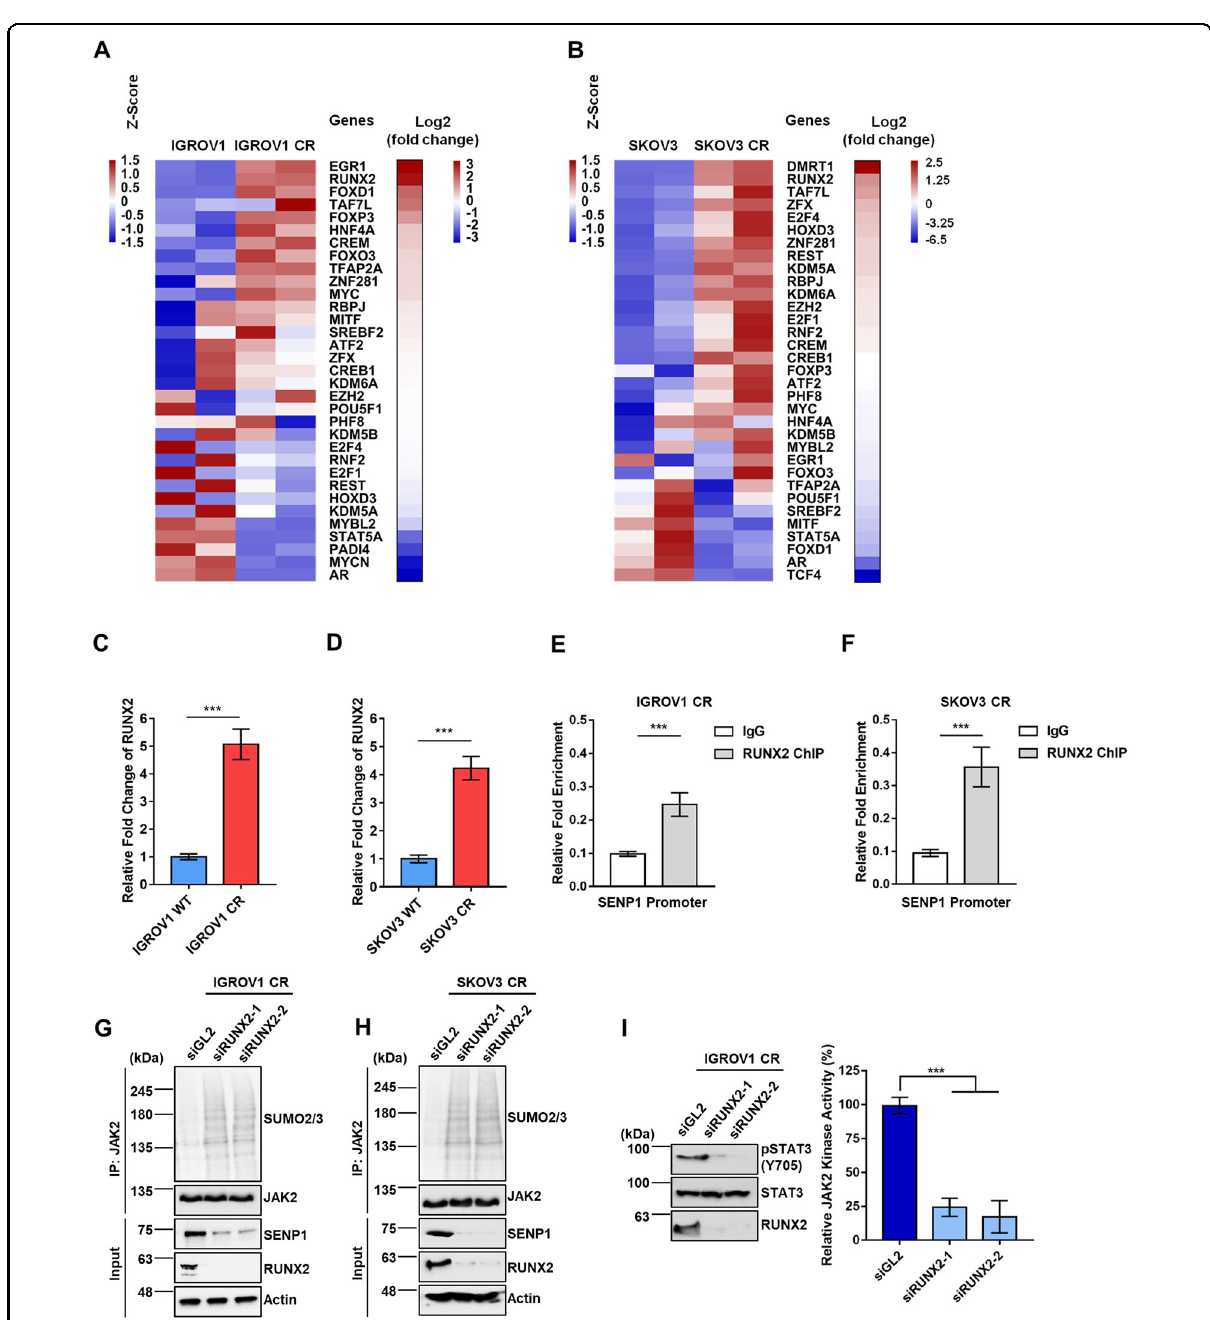
Fig. 5 Transcription factor RUNX2 regulates SENP1 expression in cisplatin-resistant ovarian cancer cells. A Heat map of transcription factors of SENP1 in IGROV1 CR/ IGROV1 cells and ( B ) SKOV3 CR/SKOV3 cells. Transcriptional factors were identi fi ed from database (http://amp.pharm.mssm. edu/Harmonizome/gene/SENP1) and matched with their mRNA expression values by RNA-Seq analyses. Colors in the heat map represent the mRNA expression levels after z-score normalization across different samples. C SENP1 mRNA expression levels are signi fi cantly downregulated in IGROV1 CR and ( D ) SKOV3 CR cells treated with siRUNX2. mRNA expression levels were assessed by qPCR. ***, p < 0.001. E ChIP assay to detect the association of RUNX2 with promoter regions of SENP1 in IGROV1 CR cells and ( F ). SKOV3 CR cells. Cells were harvested and cell lyses were immunoprecipitated against IgG and anti-RUNX2 antibodies. RUNX2-associated DNA were examined by qPCR. Data were represented as mean ± SD ( n = 3). ***, p < 0.001. G SENP1 protein expression levels are downregulated in IGROV1 CR and ( H ). SKOV3 CR cells treated with siRUNX2. I RUNX2 knockdown decreases pSTAT3 (Tyr705) by JAK2 in vitro. Recombinant STAT3 was incubated with puri fi ed JAK2 from IGROV1 CR cells treated with siGL2, siRUNX2-1, or siRUNX2-2 for in vitro kinase assay as described in “ Materials and Methods ” . Right panel, Quanti fi cation of pSTAT3 (Tyr705) levels in three independent experiments. ***, p <